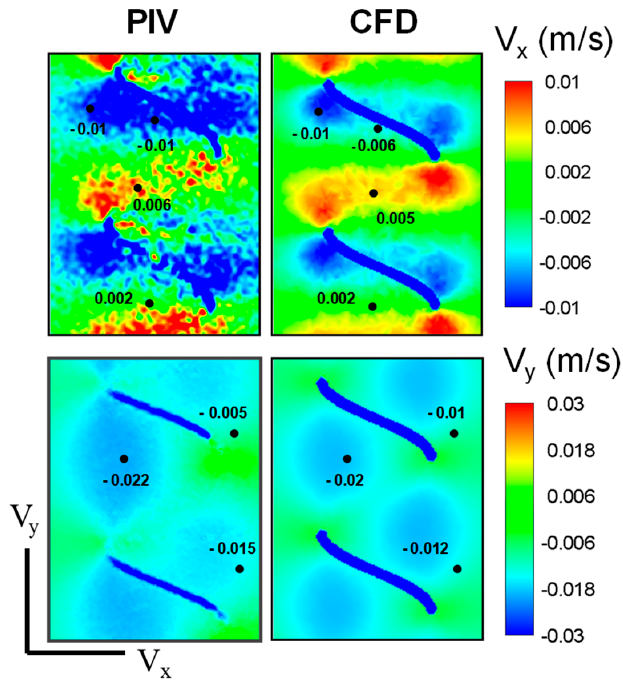
Figure 4. Comparison of radial (V x ) and axial (V y ) velocity components measured and computed with PIV measurements and computational fluid dynamics (CFD) simulations, respectively for D1 (single helix) configuration.